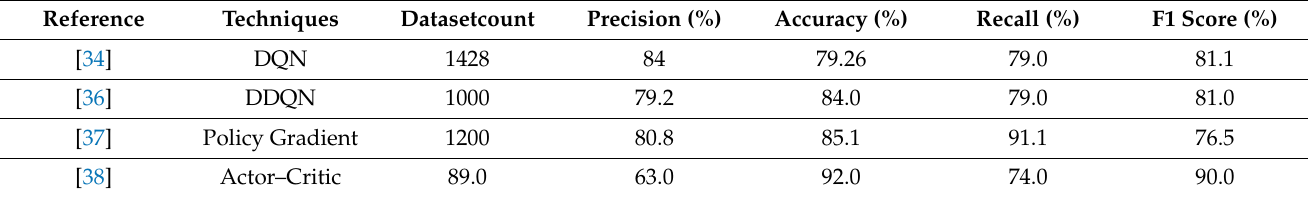
Table 2. Data analysis for the detection of monkeypox disease detection for the classification